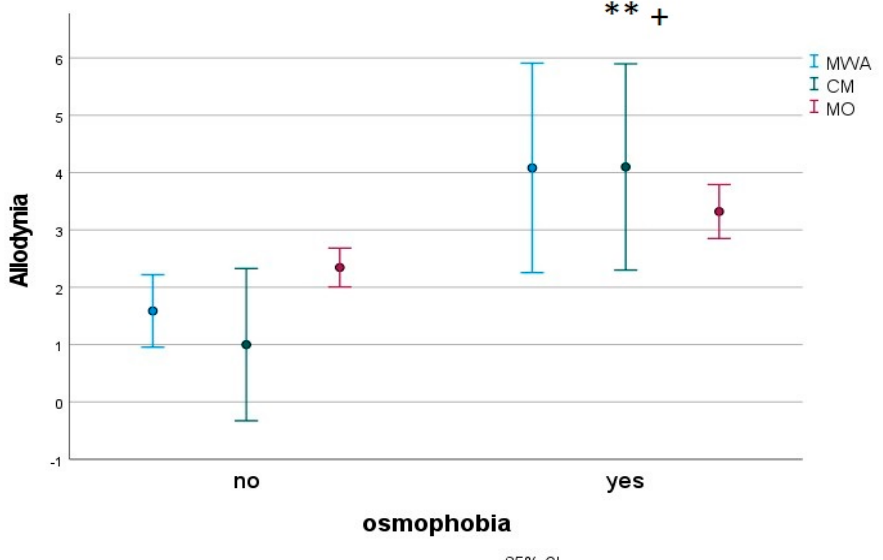
Figure 7. Mean and 95% C.I. of Allodynia scores in osmophobic and non-osmophobic migraine children. MWA: migraine with aura; MO: migraine without aura; CM: chronic migraine. Results for osmophobia as a factor ** F 0.87, p = 0.028; + osmophobia and diagnosis F 6.2, p = 0.002.